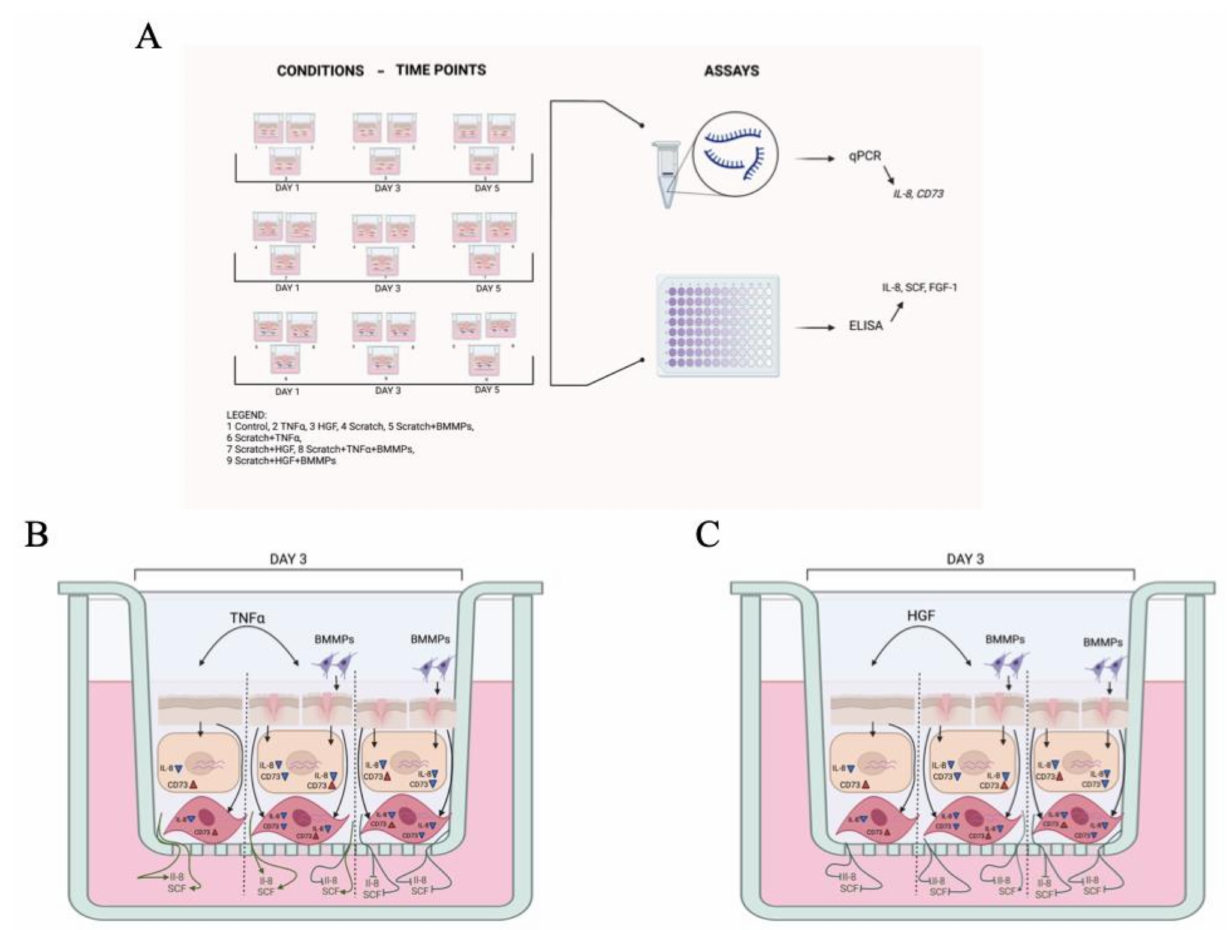
Figure 8. ( A ) Experimental wound model. Schematic representation of the nine experimental condi- tions: unscratched skin (control, TNF α , and HGF supplemented), scratched skin (scratched, TNF α , and HGF supplemented), and scratched skin and BMMPs infused (scratched, TNF α , and HGF sup- plemented, followed by BMMPs infusion). The scheme also shows the three time points taken into consideration (days one, three, and five after wound infliction). qPCR and ELISA were performed to measure expression levels of IL-8 and CD73 and protein levels of IL-8, SCF, and FGF-1, respectively ( B ). Schematic representation of the different experimental conditions on skin models on day three after wound infliction ( C ). The schemes show the effect of TNF α ( A ) and HGF ( B ) supplementation and BMMPs infusion with and in absence of damage. Evaluation of their effects was conducted at molecular level, by gene expression level quantification of IL-8 and CD73 , and at protein level measurement of IL-8 and SCF. Created with BioRender.com. https://biorender.com/ (accessed on 15 November